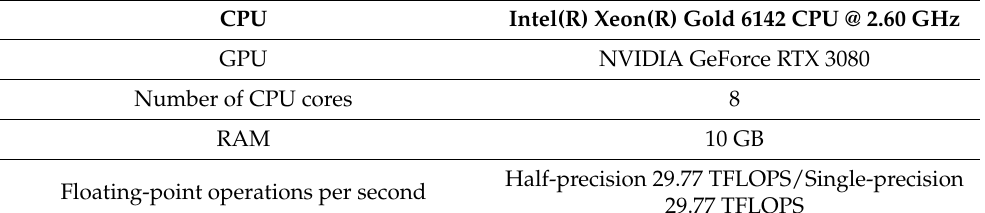
Table 3. GPU cloud server